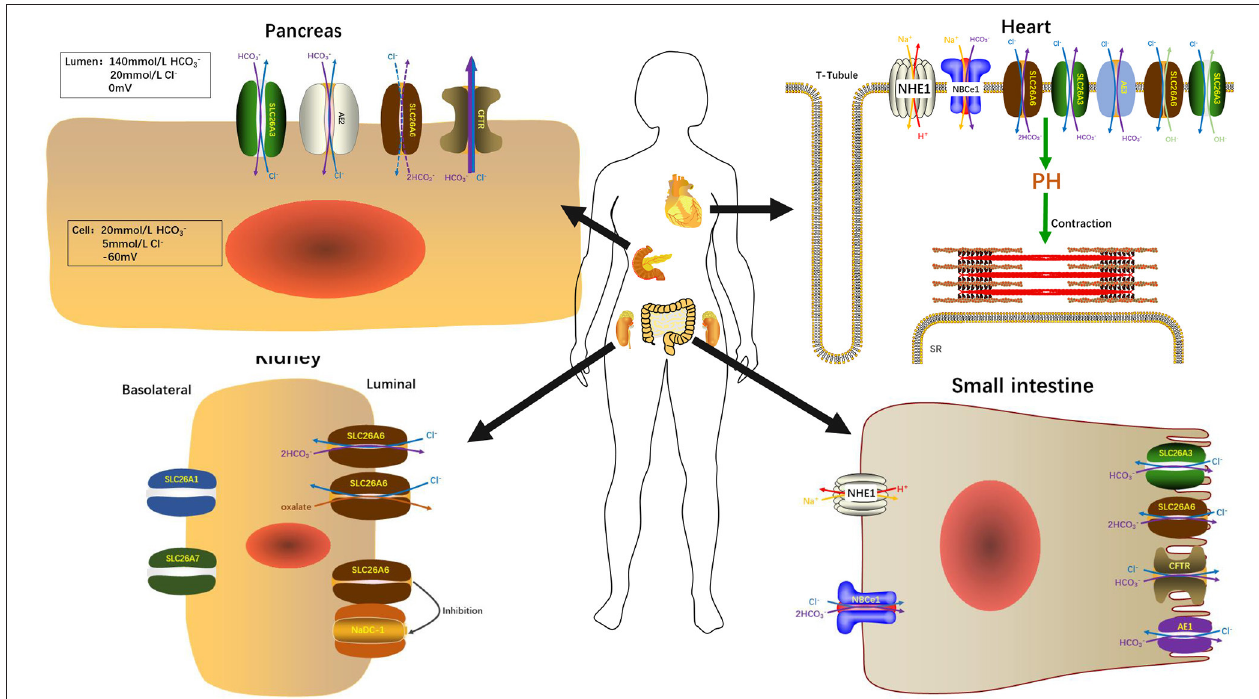
FIGURE 2 | SLC26A6 participates in the maintenance of normal organ function in the pancreas, kidneys, heart, and small